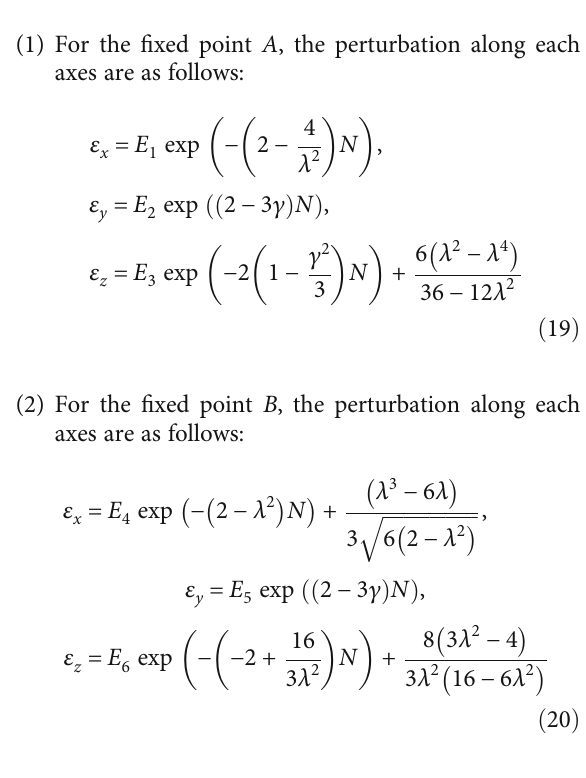
) against N for fi xed point A at λ = 1 : 55 x